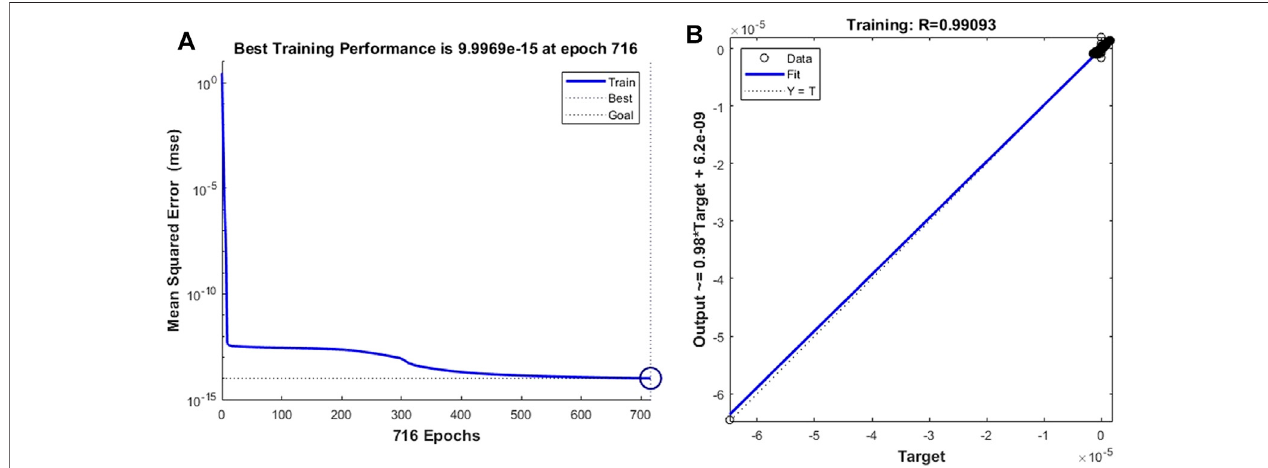
FIGURE 14 | Training performance and fi tting curve of the leukocyte transmigration prediction model used for the prediction of drag force to cells (A) Training performance; (B) Fitting curve.